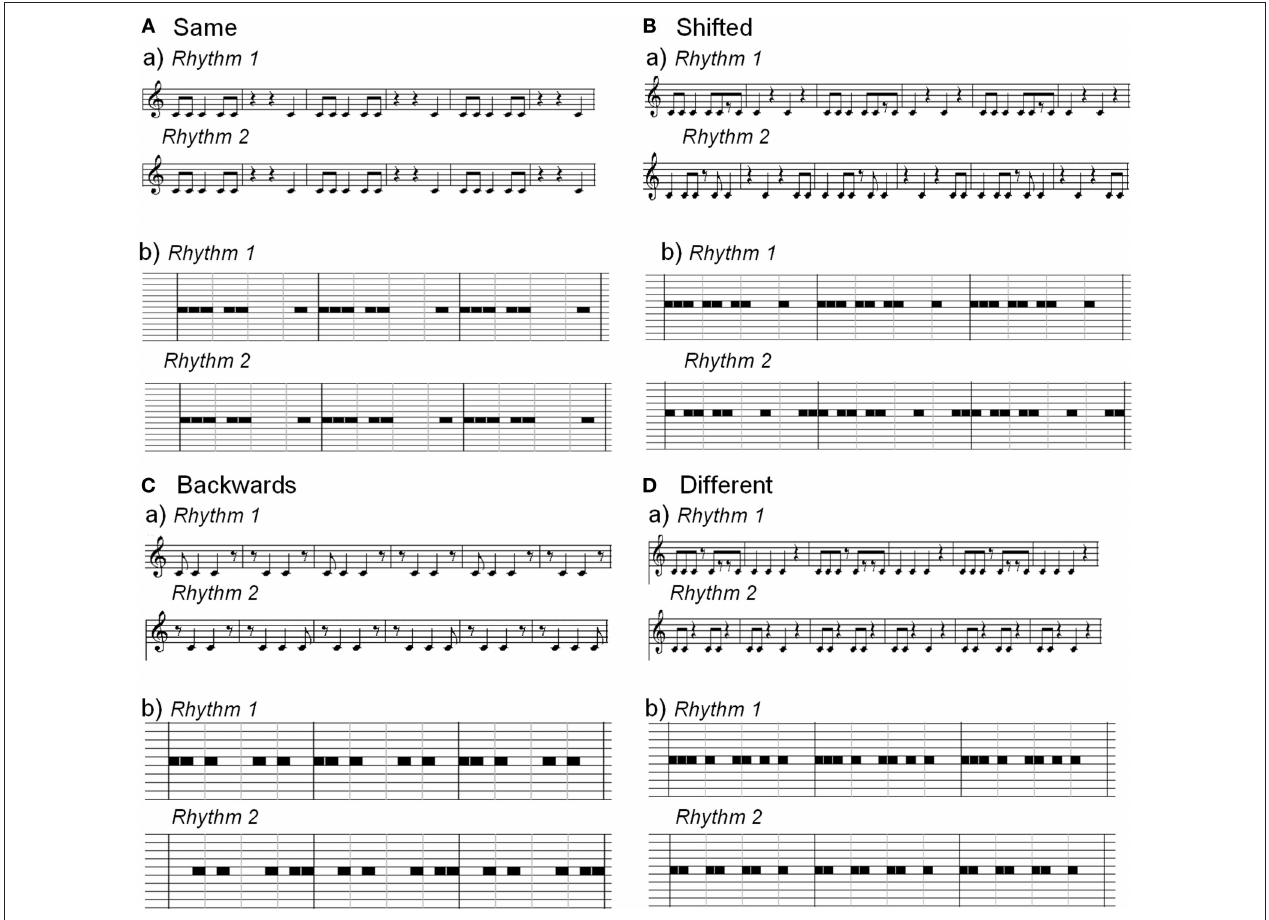
Figure 2 | examples of the rhythmic stimuli in (a) western and (b) graphic notation. (A) Same trials. (B) Shifted trials. (C) Backward trials (retrograde). (D) Different